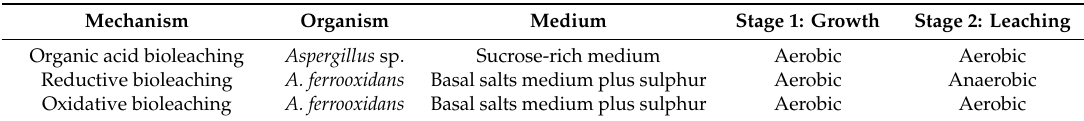
Table 2. Summary of bioleaching set up